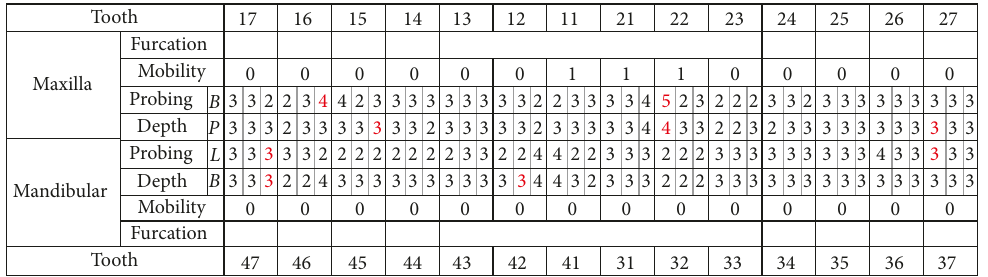
Figure 5: The periodontal examinations after periodontal treatment are shown. The red color indicates bleeding on